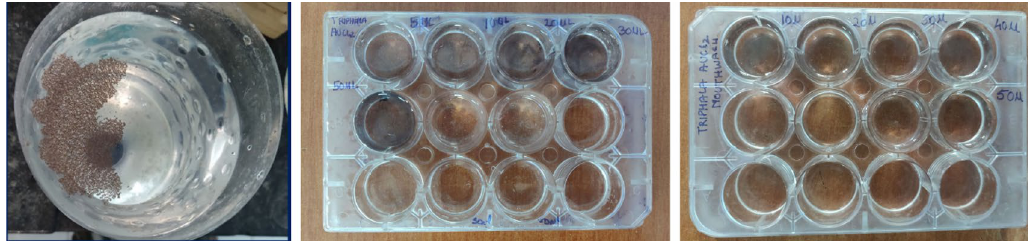
(left), AuNP’s with A.nauplii (centre) , Mouthwash with A.nauplii (right).